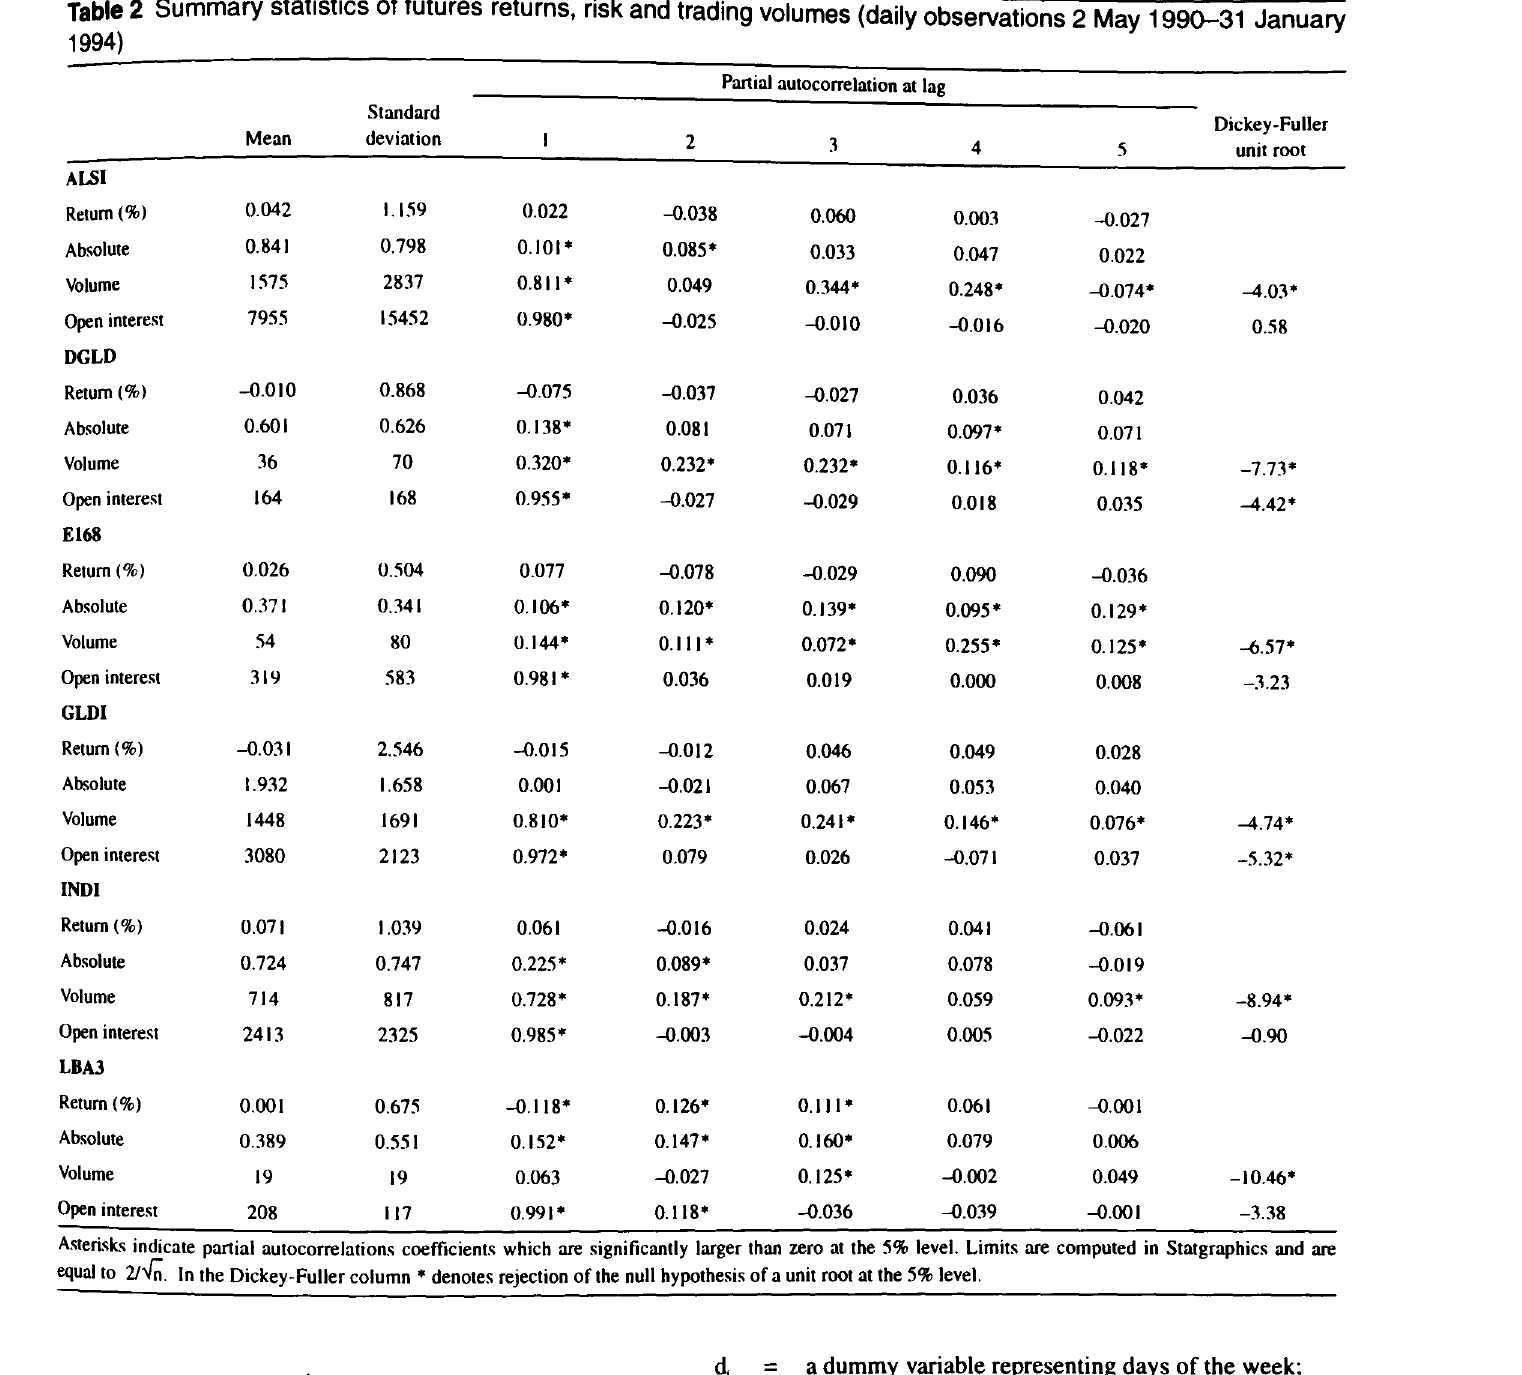
Table 2 Summary statistics of futures returns, risk and trading volumes (daily observations 2 May 1990-31